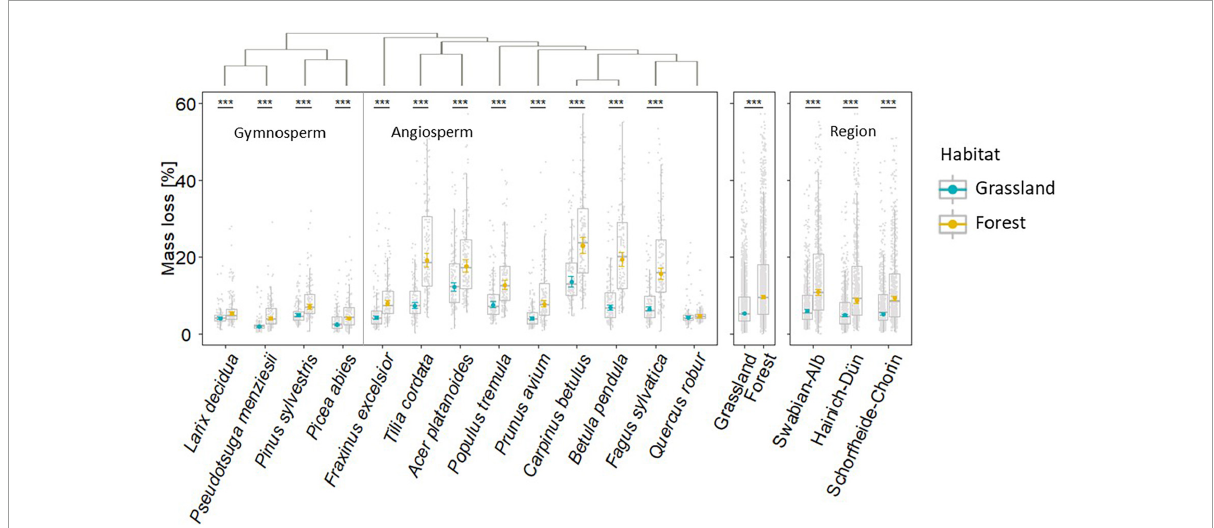
FIGURE2 Mass loss of deadwood of 13 temperate tree species exposed in 150 grassland and 150 forest habitats ( n = 3,669). Gray dots indicates measured field observation data and yellow/blue symbols the model-adjusted mean and 95% confidence intervals of each mean. Plot details were summarized in materials and methods section. Significant differences in mass loss within, between grassland and forest habitats and regions based on linear mixed effect model using Satterthwaite’s method (*** p ≤ 0.001). Tree species-specific phylogenetic information (above mass loss) was taken from Kahl et al. (2017). For detailed significance results see Table 2 and Supplementary Table 4 .